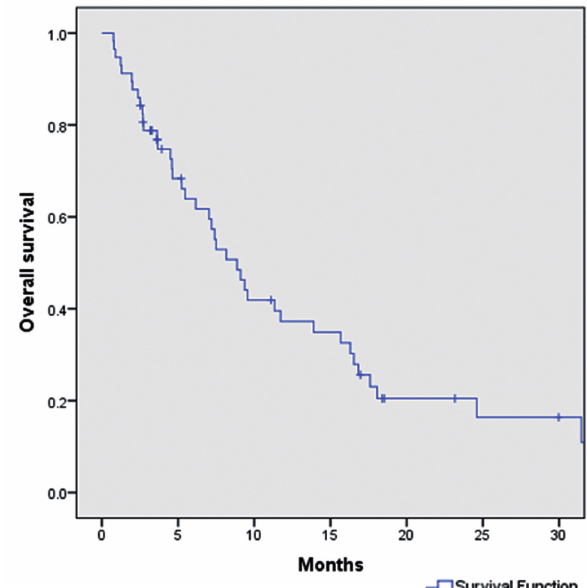
Figure 1 - Kaplan-Meier estimates of overall survival was 8.16 months (95% confidence interval,